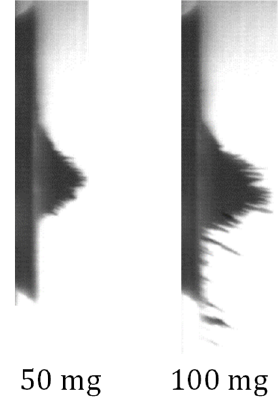
Figure 7. Shapes of two bulks after they were attracted again.